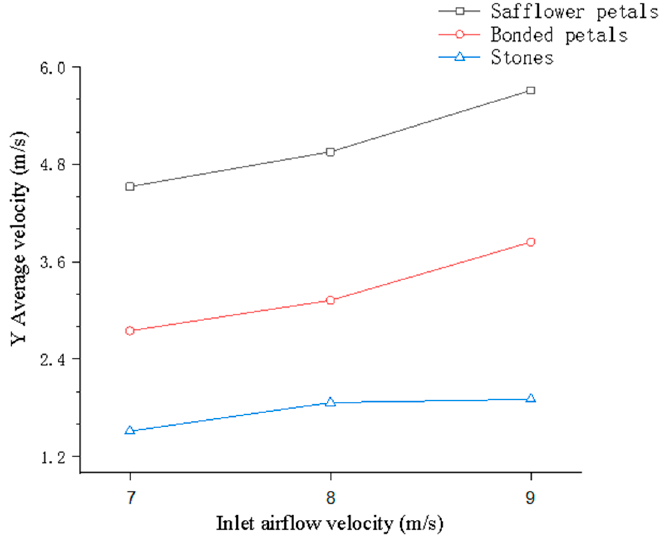
Figure 17. Influence of inlet airflow velocity on the axial average velocity of the mixture components.